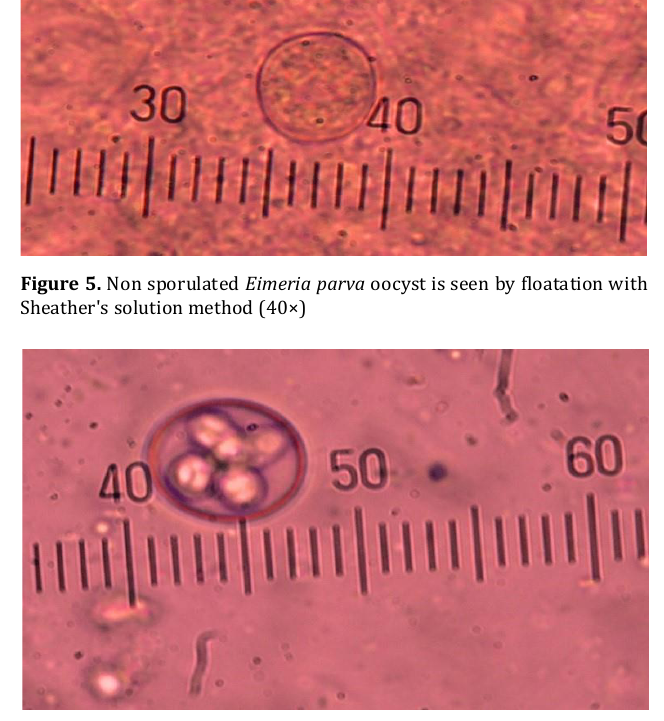
Figure 6. Sporulated Eimeria parva oocyst is seen by floatation with Sheather's solution method (40×)